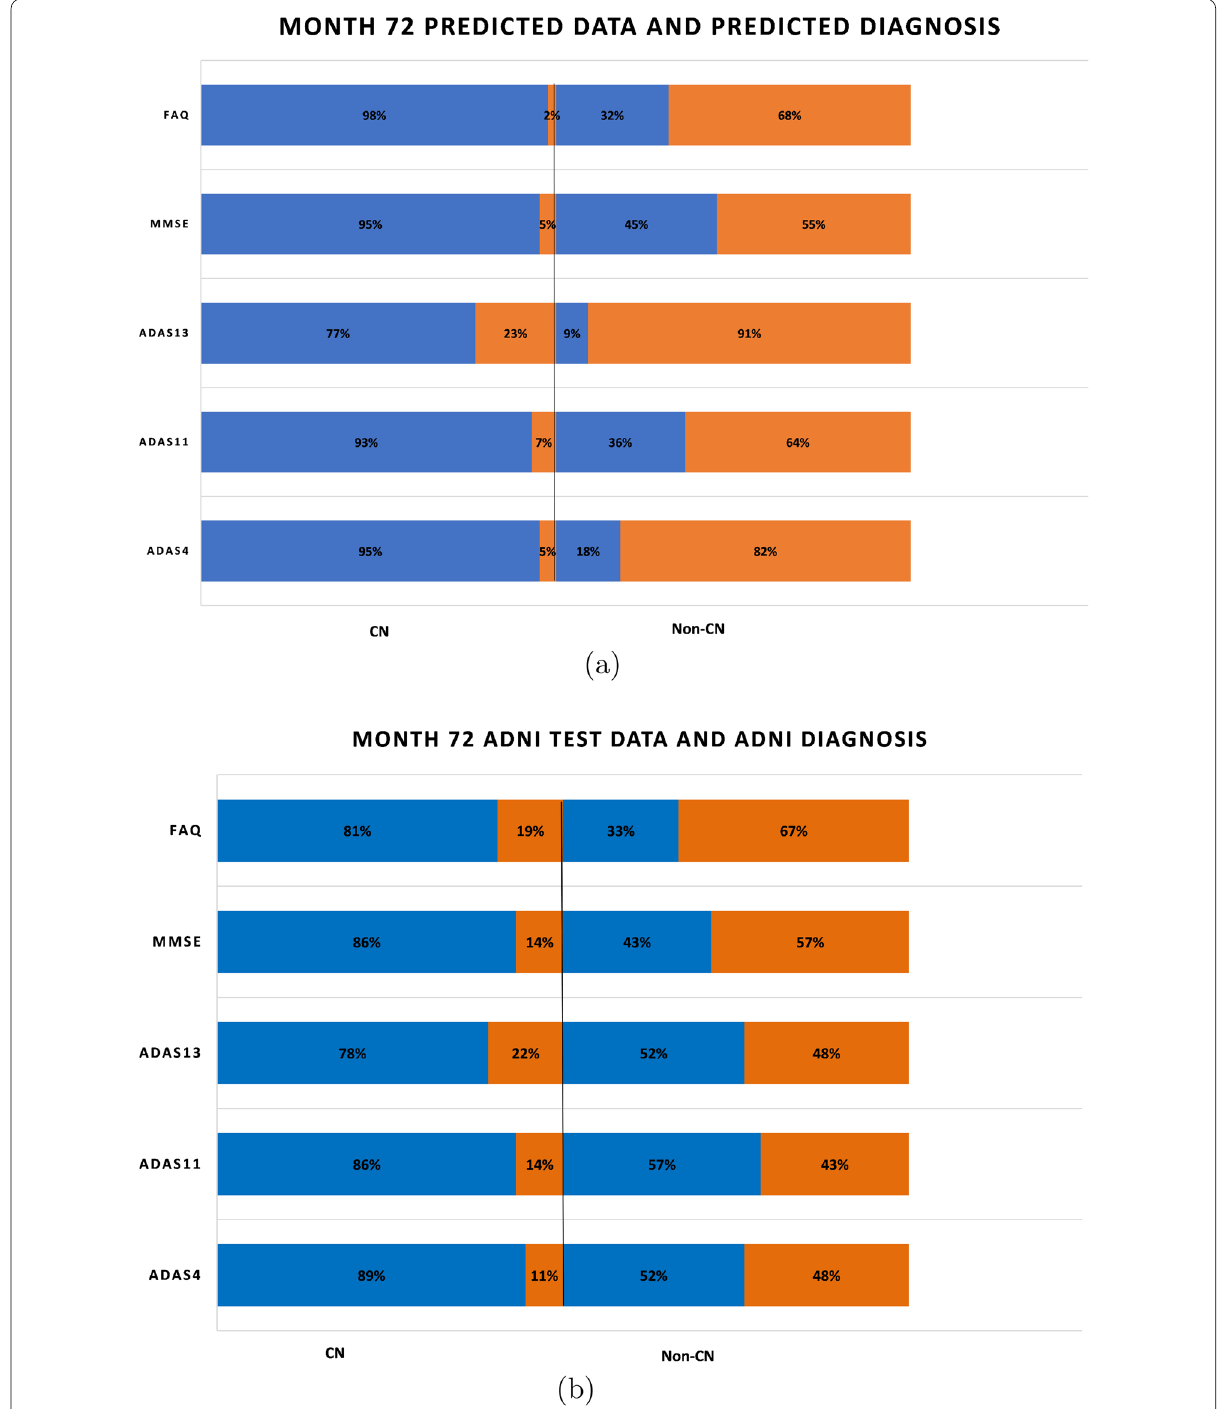
Fig. 17 Proportion of correct and incorrect diagnosis in CN and non-CN categories for test data and predicted test data at month